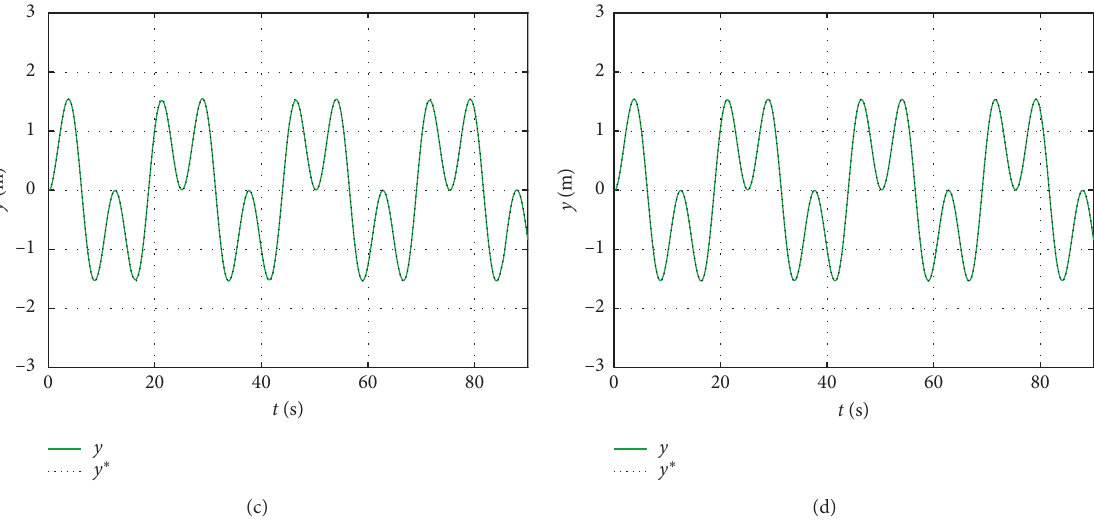
Figure 8: Tracking of planned reference trajectories for X and Y directions. (a) Trajectory tracking in X case 1. (b) Trajectory tracking in X case 2. (c) Trajectory tracking in Y , case 1. (d) Trajectory tracking in Y , case 2.